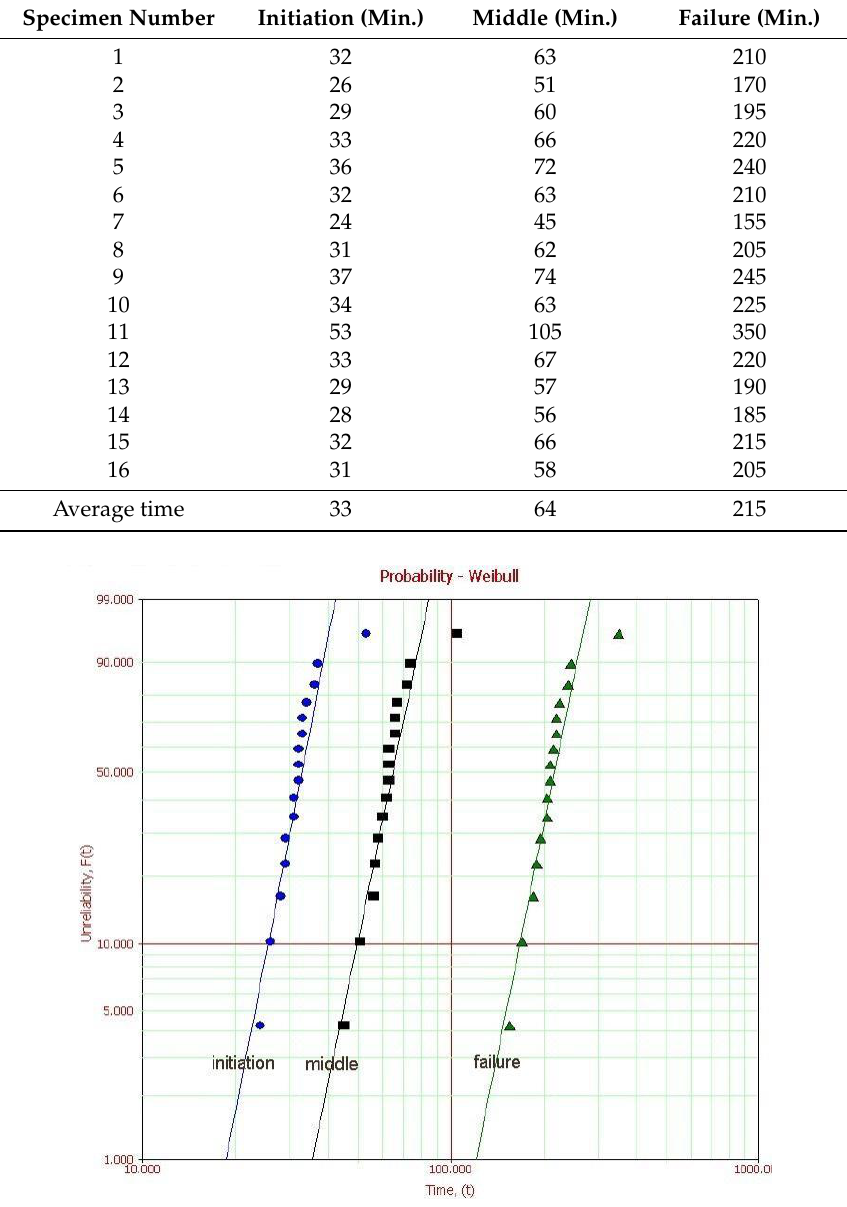
Figure 10. Time to failure of the Weibull distribution of tree model 2 (divided by three progress: initiation, middle, failure).